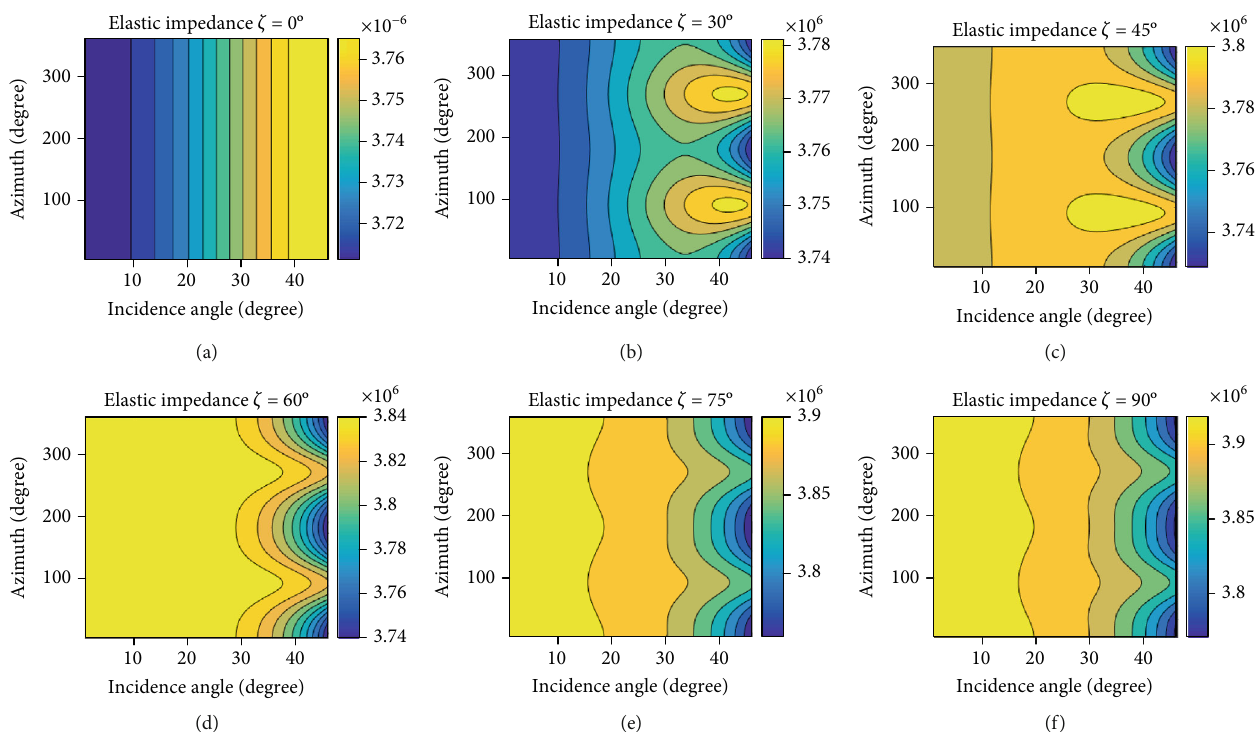
Figure 6: The e ff ect of dip angle of symmetry axis in a TTI medium on the PP-wave azimuthally anisotropic EI, where (a) 0 ° (VTI), (b) 30 ° , (c) 45 ° , (d) 60 ° , (e) 75 ° , and (f) 90 ° (HTI).